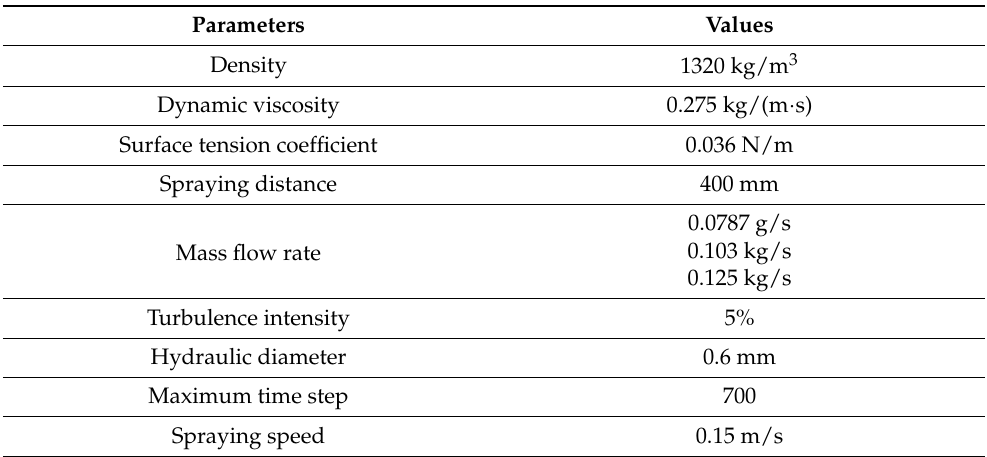
Table 1. The basic parameter settings of the numerical